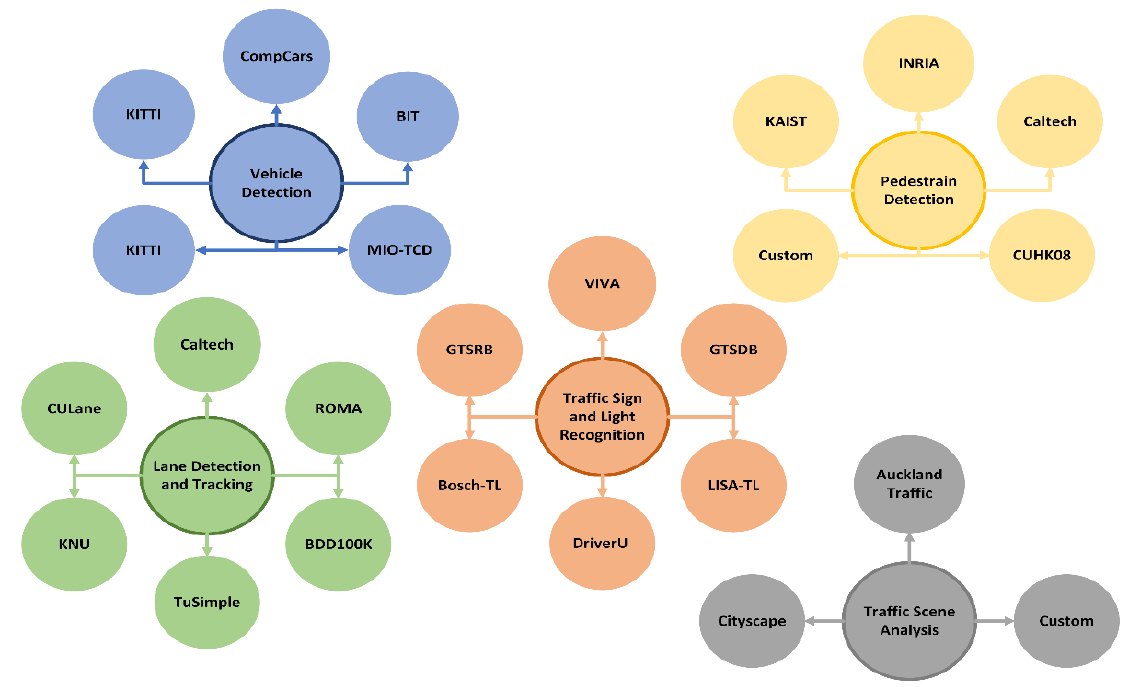
Figure 5. Clustering of dataset for subdomains of perception.